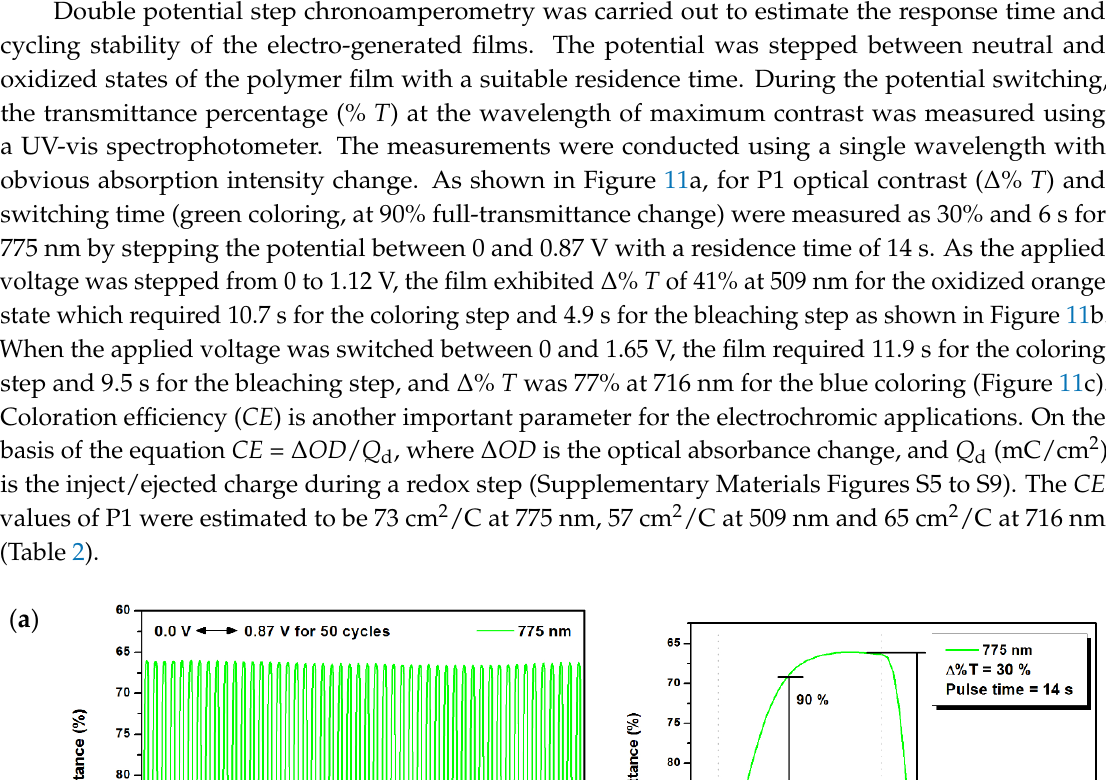
Figure 10. Spectroelectrochemistry of the electro-generated films of P2 (thickness: 170 ± 100 nm) on the ITO-coated glass substrate in 0.1 M Bu 4 NClO 4 /CH 2 Cl 2 at various applied potentials.